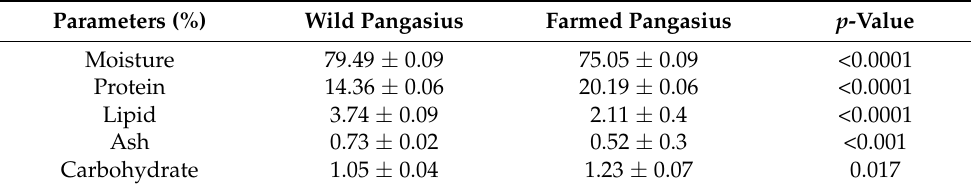
Table 1. Proximate composition (g/100 g wet weight basis) in the muscle of the wild and the farmed pangasius